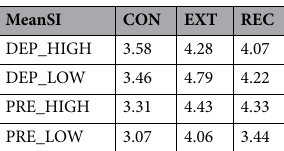
Table 6. Mean shape index of patches of different persistence categories of